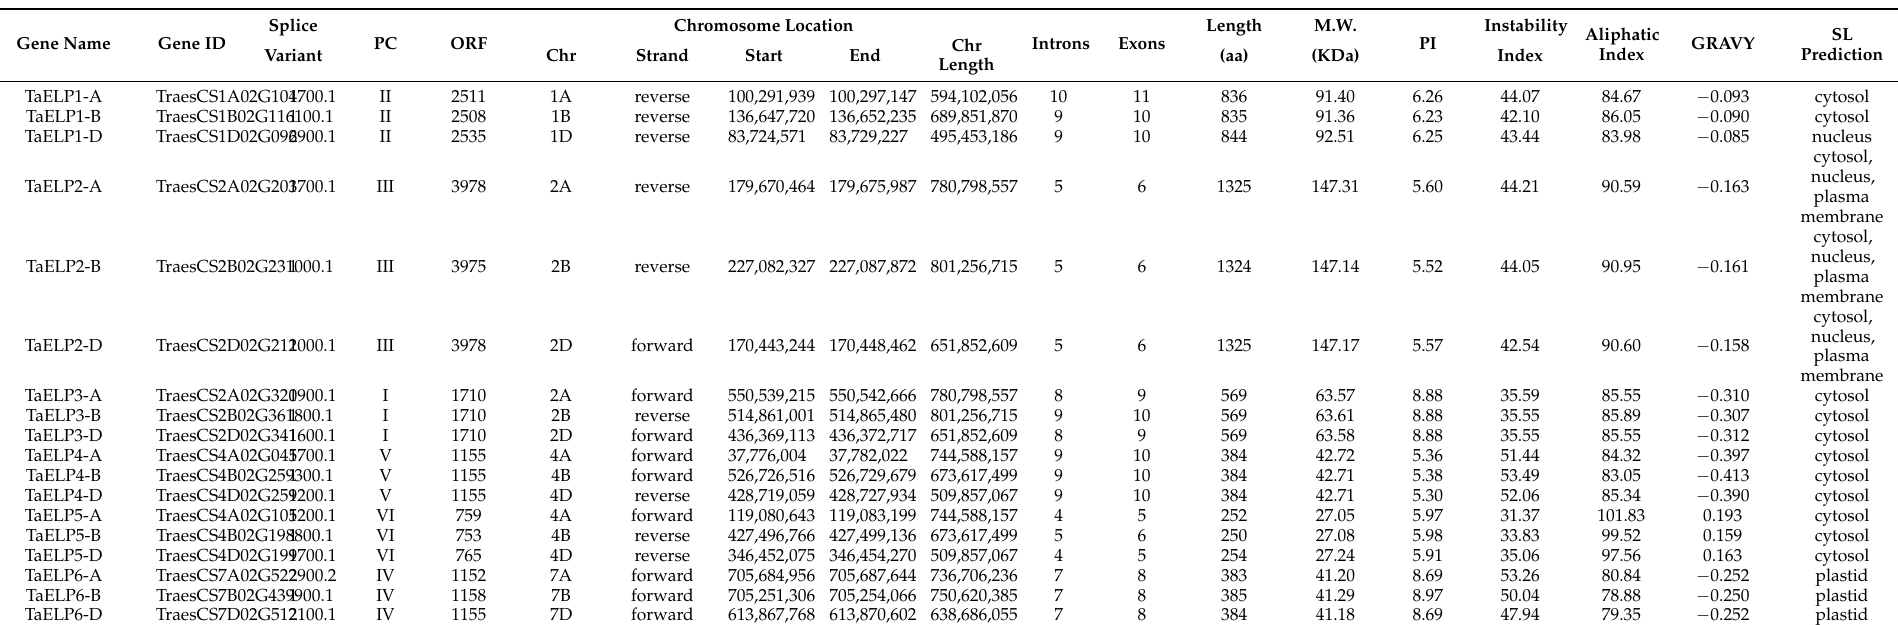
Table 1. Detailed annotation of the TaELPs in